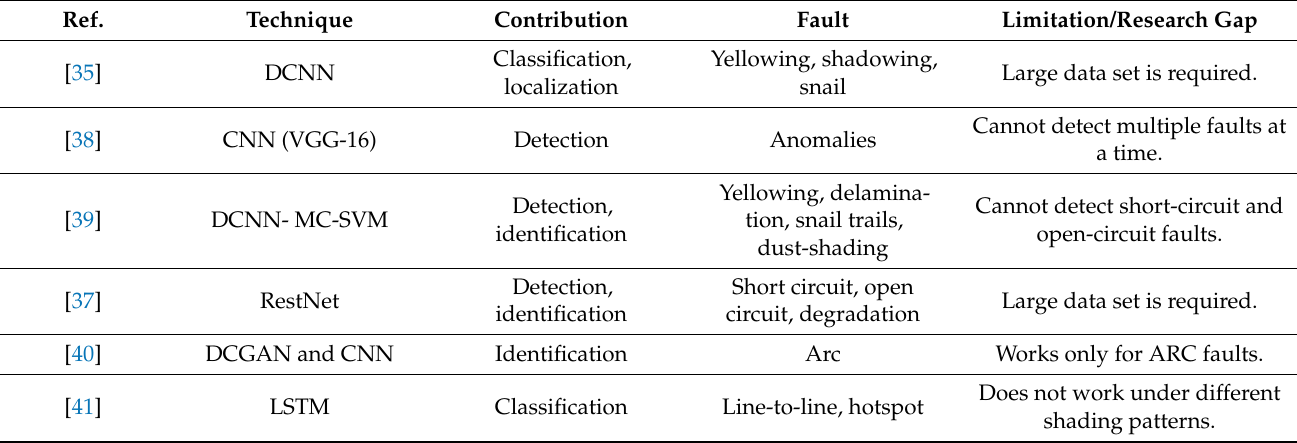
Table 2. Applications of DL for PV